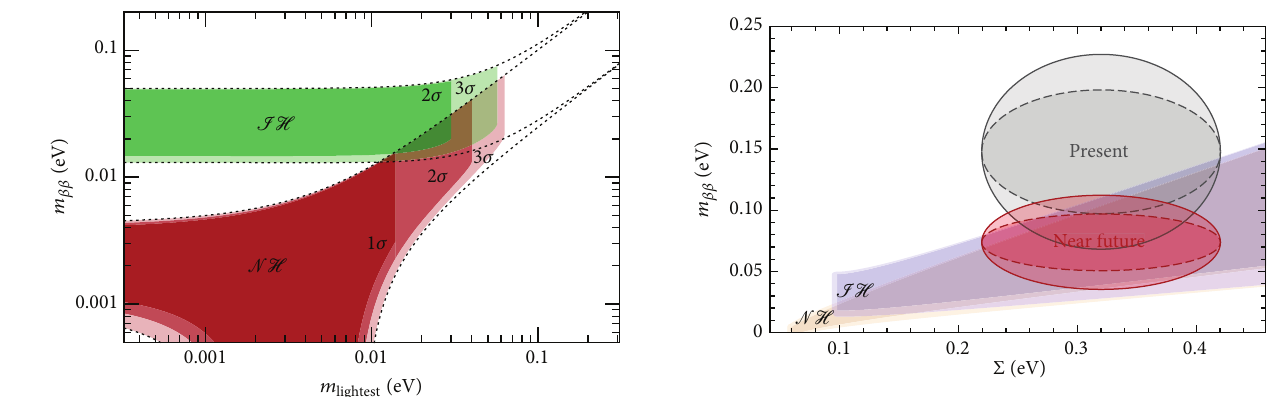
Figure 20: Constraints from cosmological surveys are added to those from oscillations in the representation of 𝑚 𝛽𝛽 as a function of the lightest neutrino mass. The dotted contours represent the 3𝜎 regionsallowedconsideringoscillationsonly.Theshadedareasshow the effect of the inclusion of cosmological constraints at different CL. The horizontal bands correspond to the expected sensitivity for future experiments. Figure from [211].